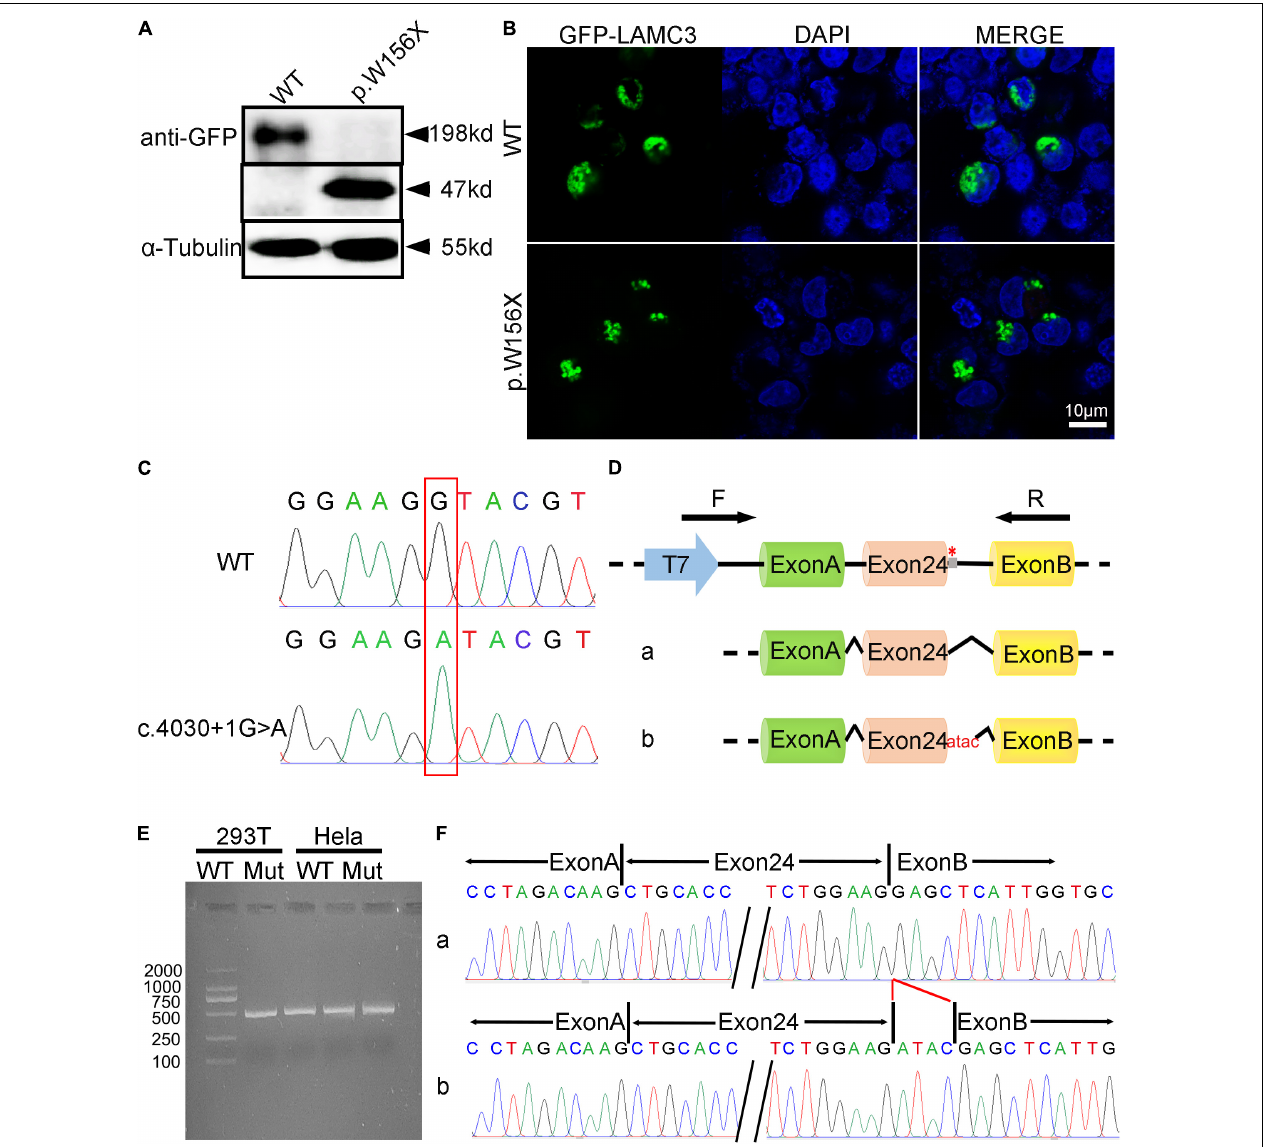
FIGURE 2 | The functional analysis of complex heterozygous variants in LAMC3 gene. (A) The LAMC3 WT group expressed a normal protein with a molecular weight of 198 kDd and a truncated protein with a molecular weight of 47 kDd in LAMC3 variant group (c.470G > A). (B) The cellular localization of LAMC3 in WT and variant group was in the cytoplasm without significant morphological difference. (C) Sanger sequence of minigene in in WT (above) and variant (below) group (c.4030 + 1G > A). (D) The schematic diagrams showed the minigene comprising intron 23, exon 24, and intron 24 of the WT or variant (c.4030 + 1G > A). The variant c.4030 + 1G > A affected the normal splicing of LAMC3 mRNA, resulting in 4 bp base (ATAC) retention at the left of intron 24, “*” represents variant location. (E) Agarose gel electrophoresis of RT-PCR fragments showed a similar length of the product between the WT and variant group. (F) The Sanger sequences showed a 4 bp base (ATAC) retention at the left of intron 24 in the variant